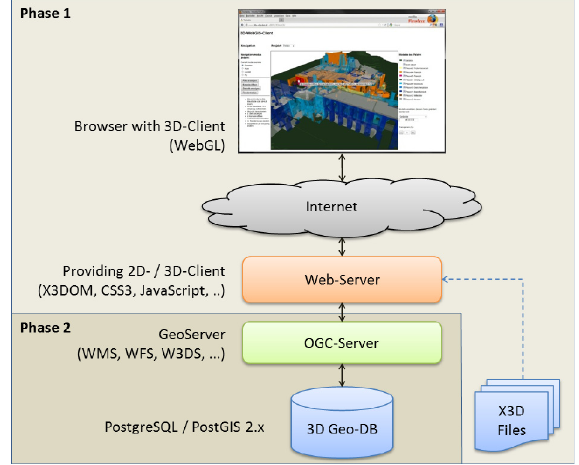
Figure 4: Client/Server architecture for the realization of a 3D WebGIS